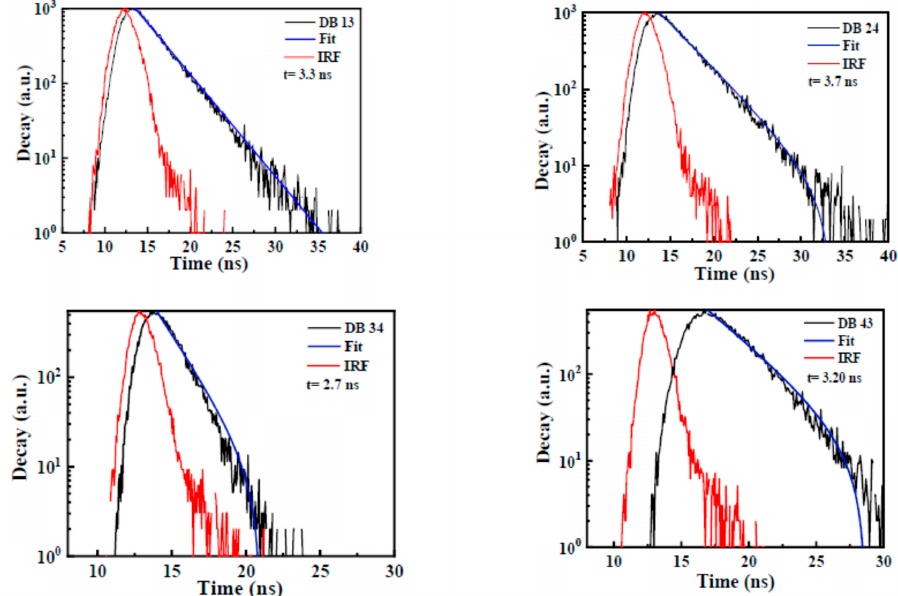
Figure 7. Time-resolved photoluminescence (TRPL) spectra for the PL decay kinetics analysis of the compounds DB 13, DB 24, DB 34, and DB 43.